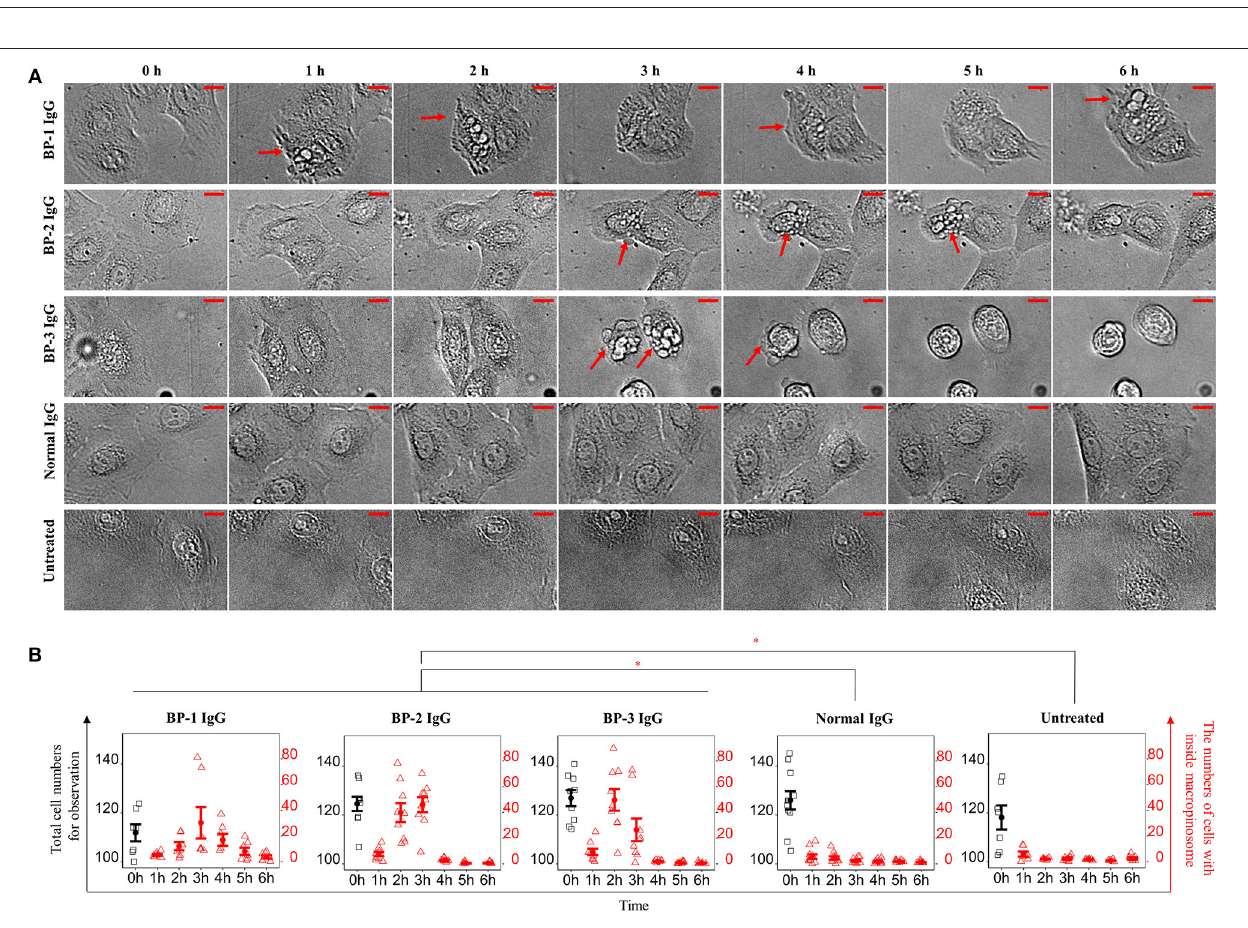
FIGURE 2 | Phase-contrast images of macropinosome formation in NHEKs treated with BP IgG. (A) Phase-contrast images were captured every 10min after the addition of IgGs obtained from three patients with BP (BP-1, BP-2, and BP-3) or normal IgG to NHEKs and culture for up to 6h. The figure shows images captured every 1h. Cells with macropinosomes were indicated with arrows. Scale bar 10 µ m. (B) The numbers of cells present during BP IgGs stimulation. Black: Total cell numbers observed at 0h. Red: Numbers of cells containing macropinosomes at the indicated time points. Two-way ANOVA was used to analyze the significance of differences induced by BP IgGs. * p -value <